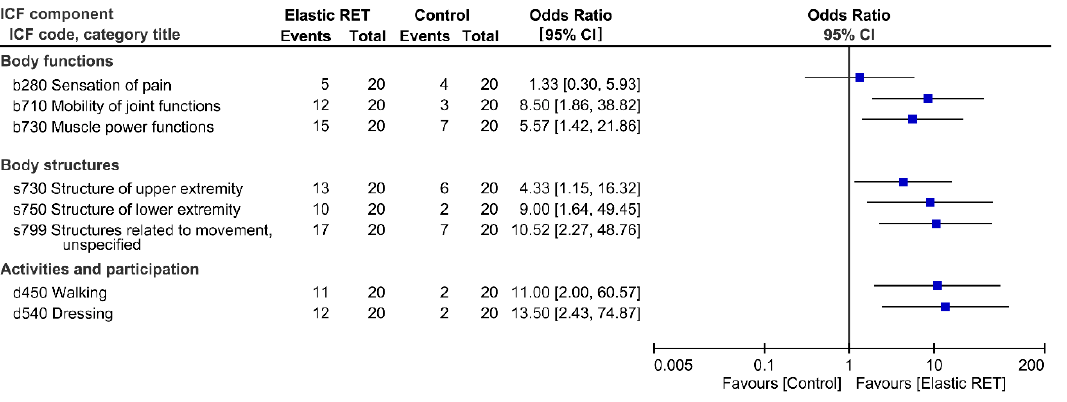
Figure 2. Effect on treatment success rate in all categories of the brief International Classification of Functioning, Disability and Health (ICF) Core Set for osteoarthritis. Each comparison result is represented as a point estimate (square box) with a 95% confidence interval (CI, horizontal line). Results plotted on the right side indicate positive effects of elastic resistance exercise training (RET).